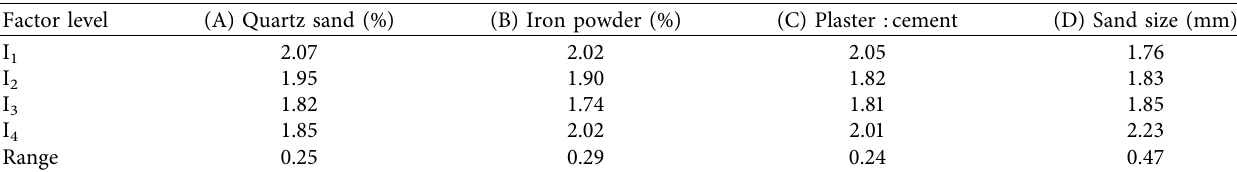
Table 8: Analysis of the compression and tensile ratios’ range of different factors under compression covered by the study. Factor level